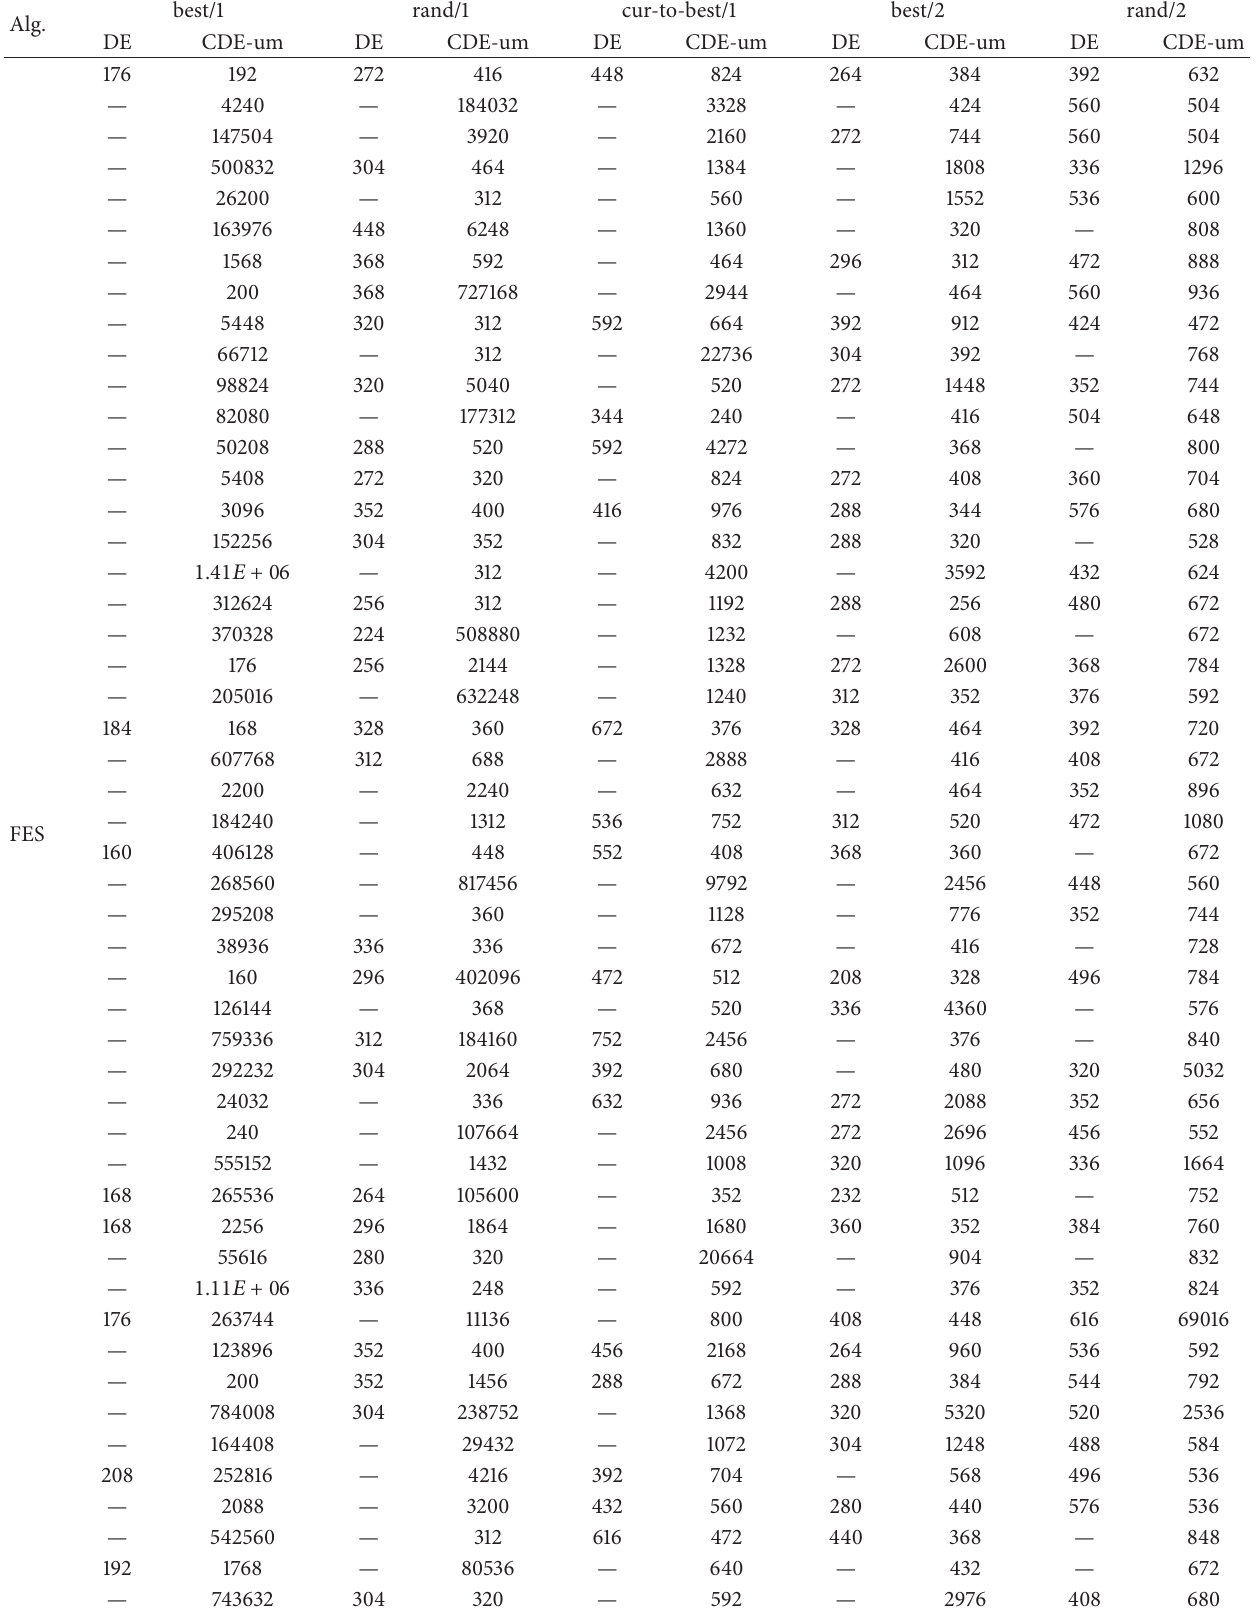
Table 1: FES to achieve the Ter Err for DE’s deceptive